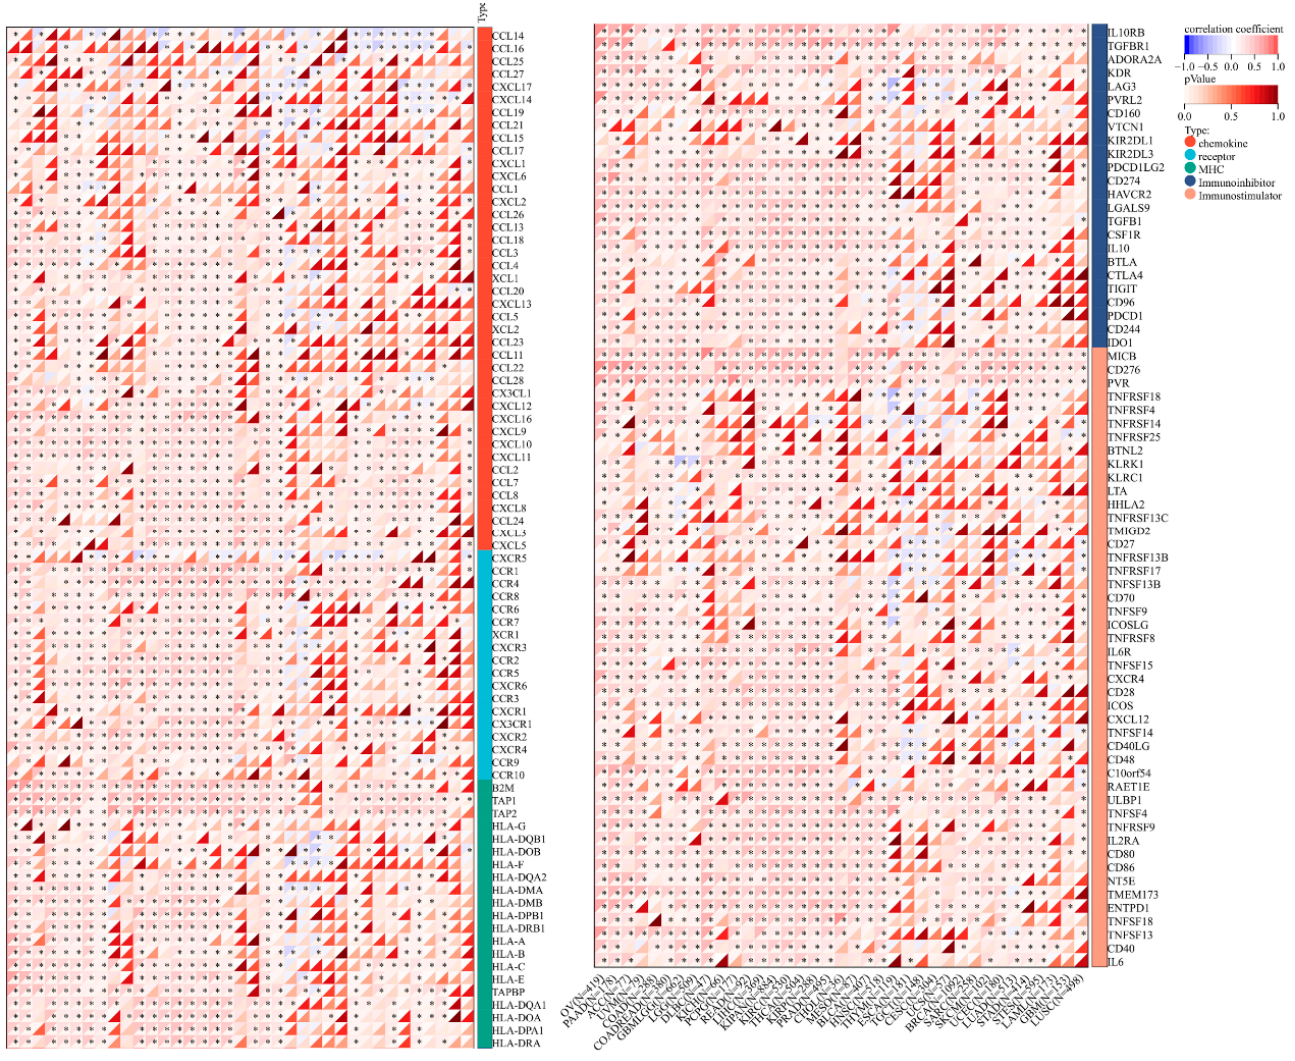
Figure 6. Pan-cancer analysis of the correlation between TUBA1B expression and immune-related genes. * p < 0.05.